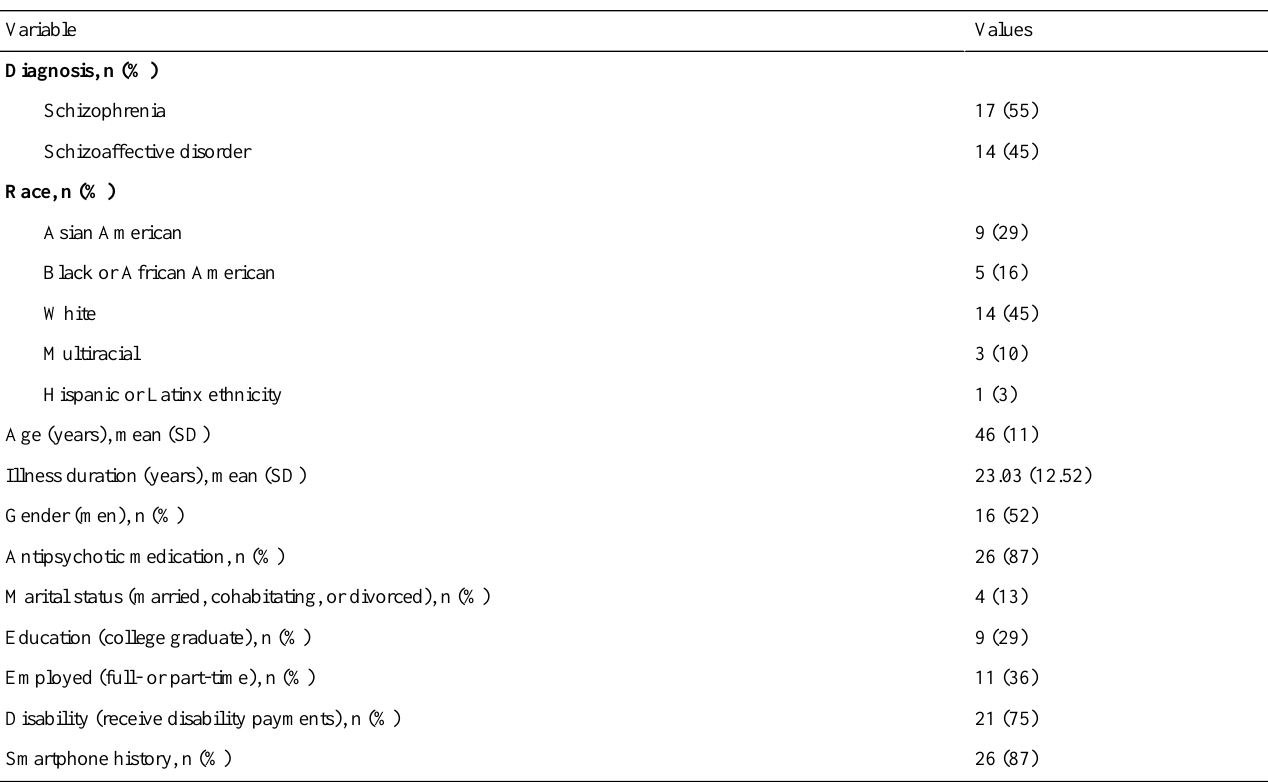
Table 1. Participant demographics and sample characteristics (n=31).